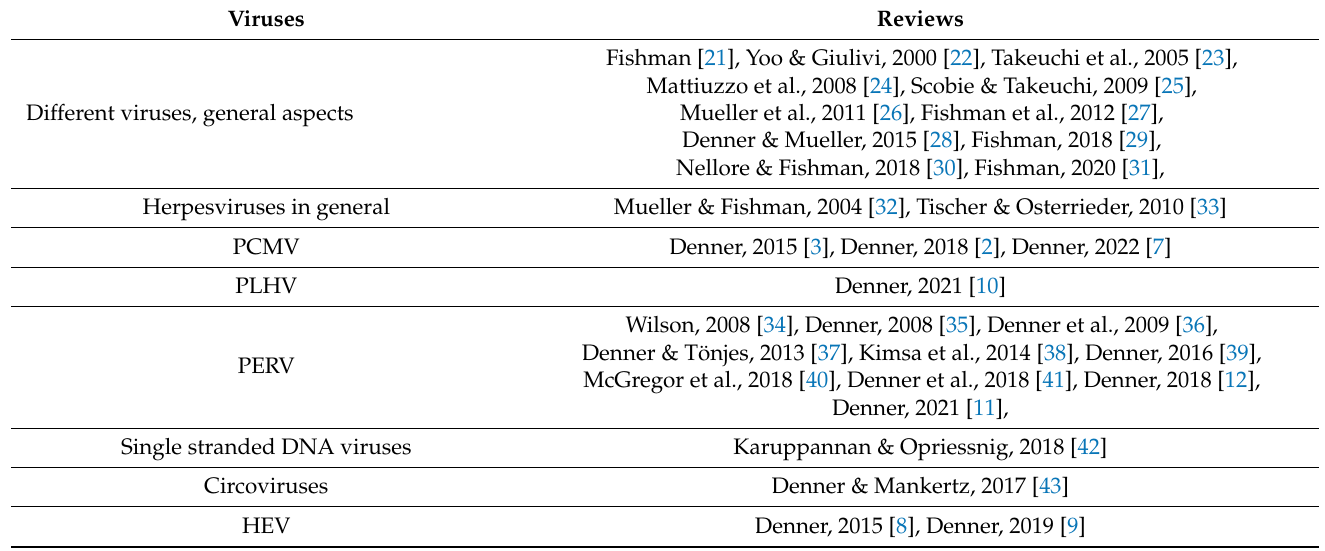
Table 1. Reviews analyzing the potential impact of porcine viruses on xenotransplantation.